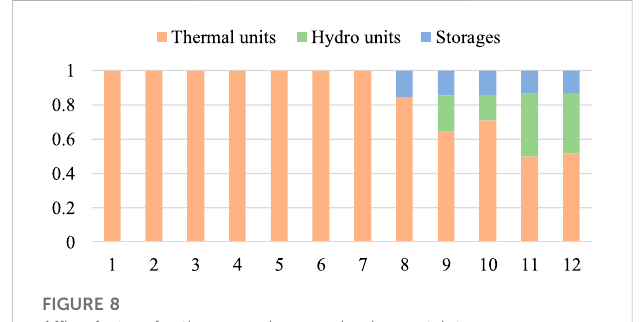
FIGURE 8 Af fi ne factors for the upward source-load uncertainty.